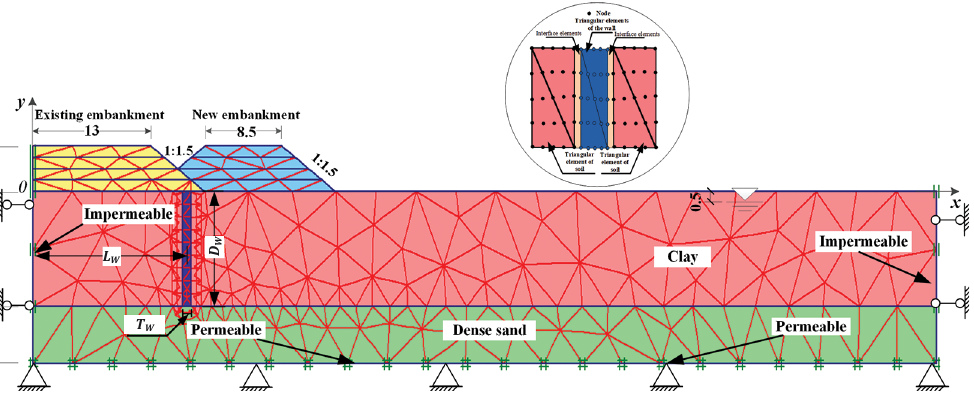
Figure 2. Numerical model Note: units in